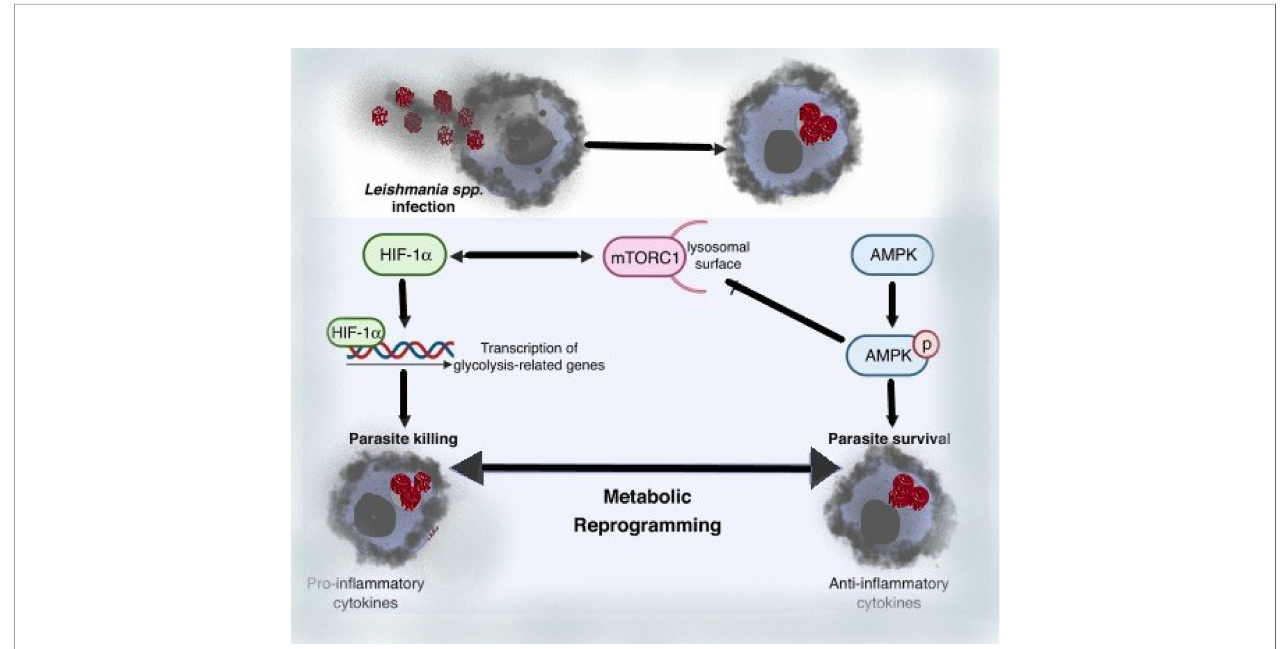
FIGURE 1 | Virulence factors of